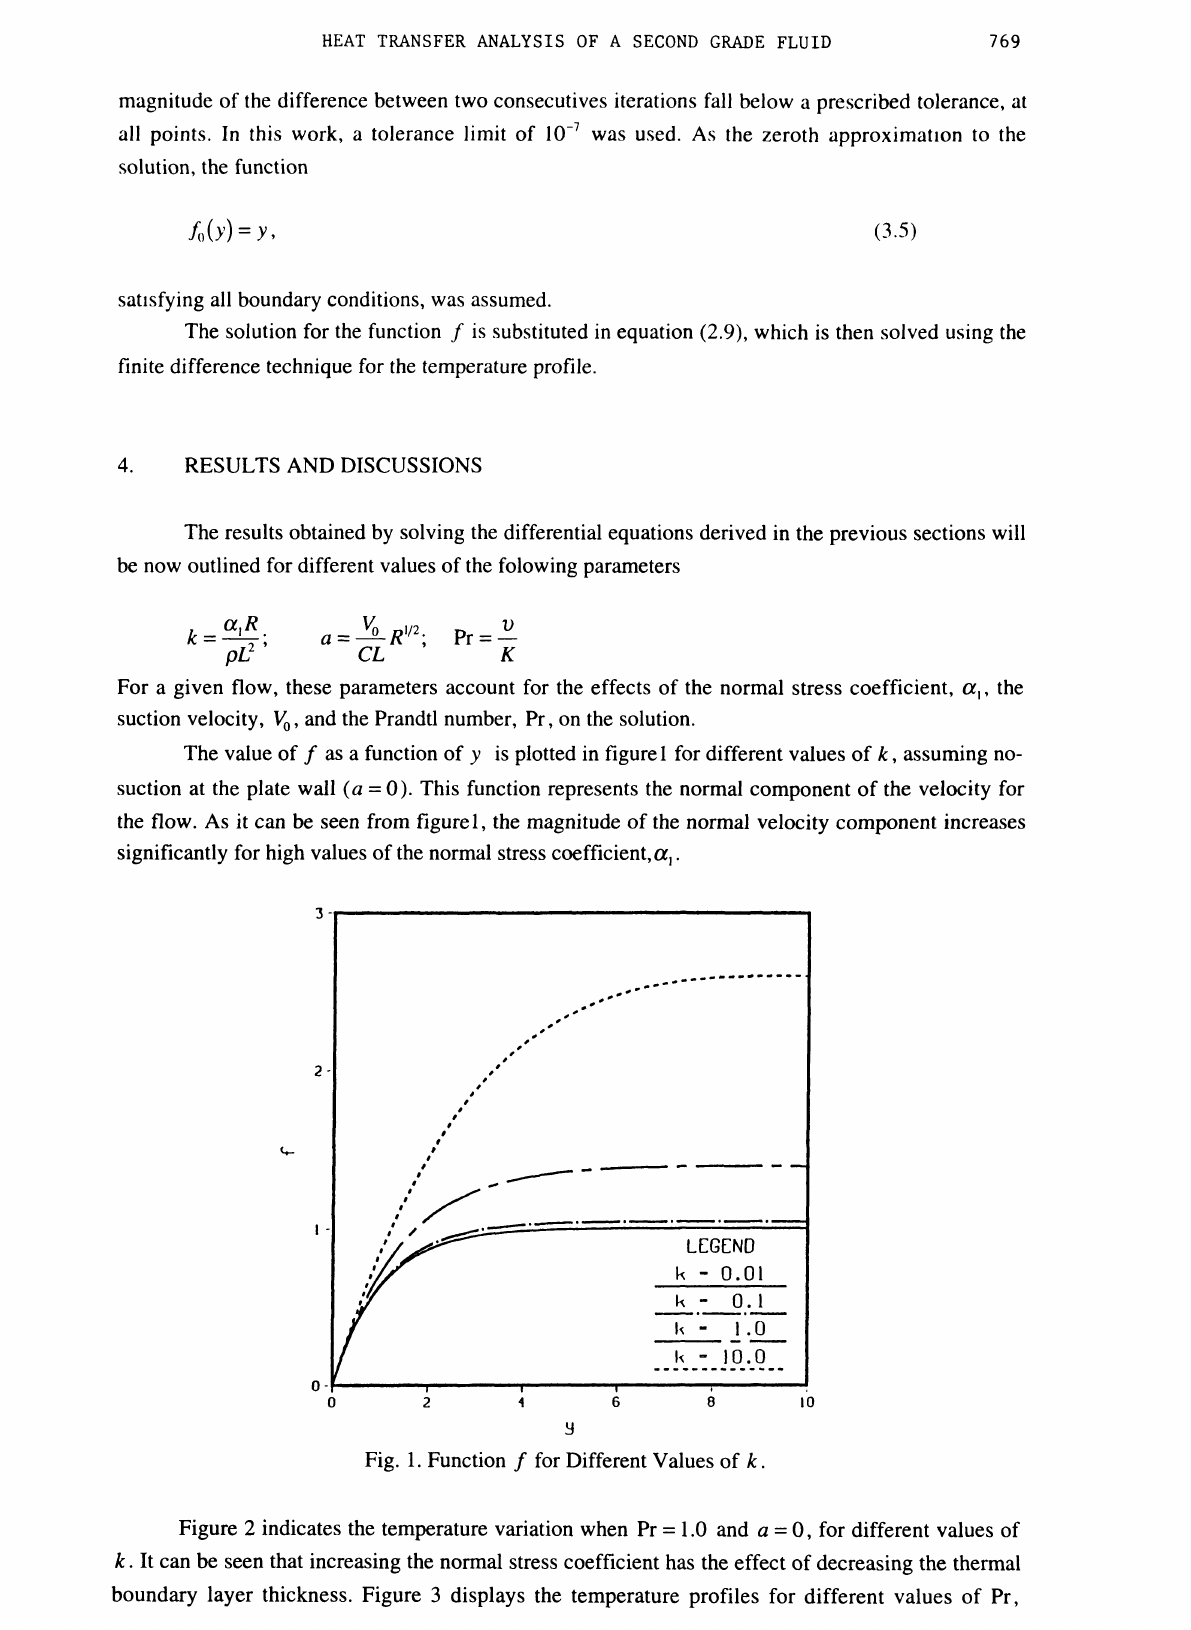
Fig. 1. Function f for Different Values of